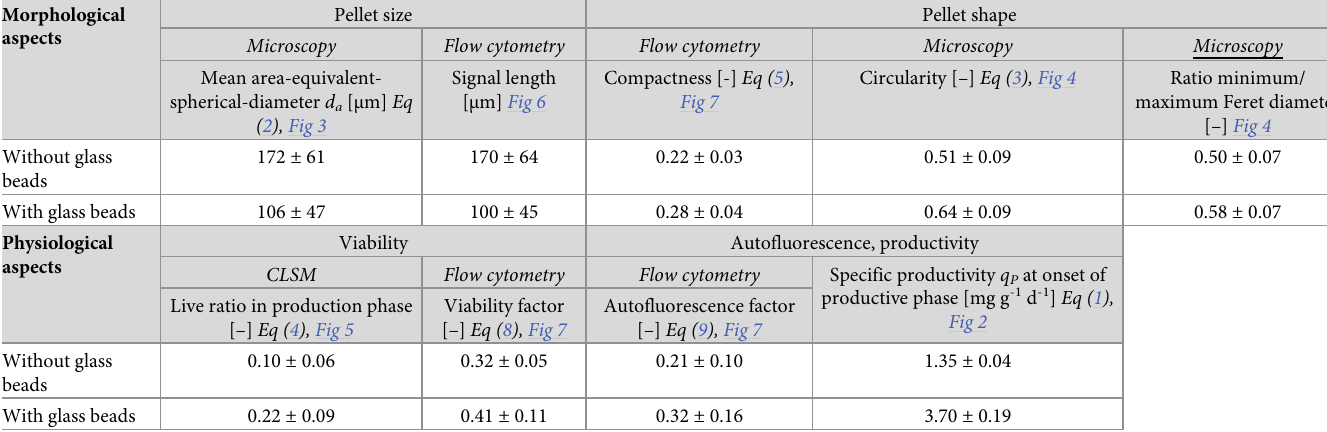
Table 1. Overview on morphological and physiological aspects obtained from pellet analysis via different analytical methods. Given values are mean values with their respective standard deviations. Morphological